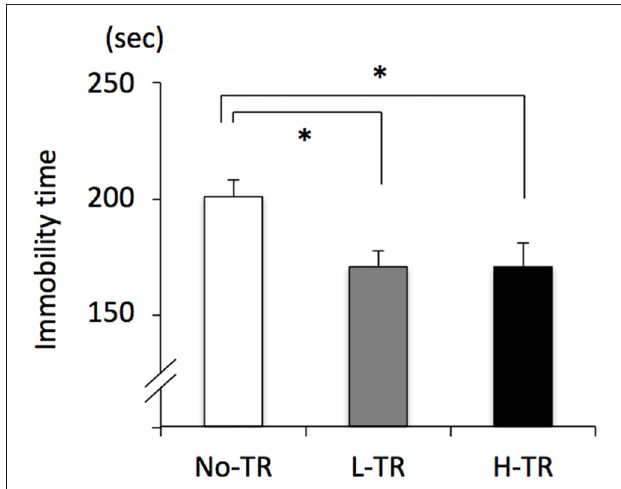
FIGURE 7 | Effects of 4 weeks of regular treadmill running at different intensities on immobility time in the forced swim test. No-TR, sedentary; L-TR, low intensity; H-TR, high intensity. ∗ p < 0.05 vs.